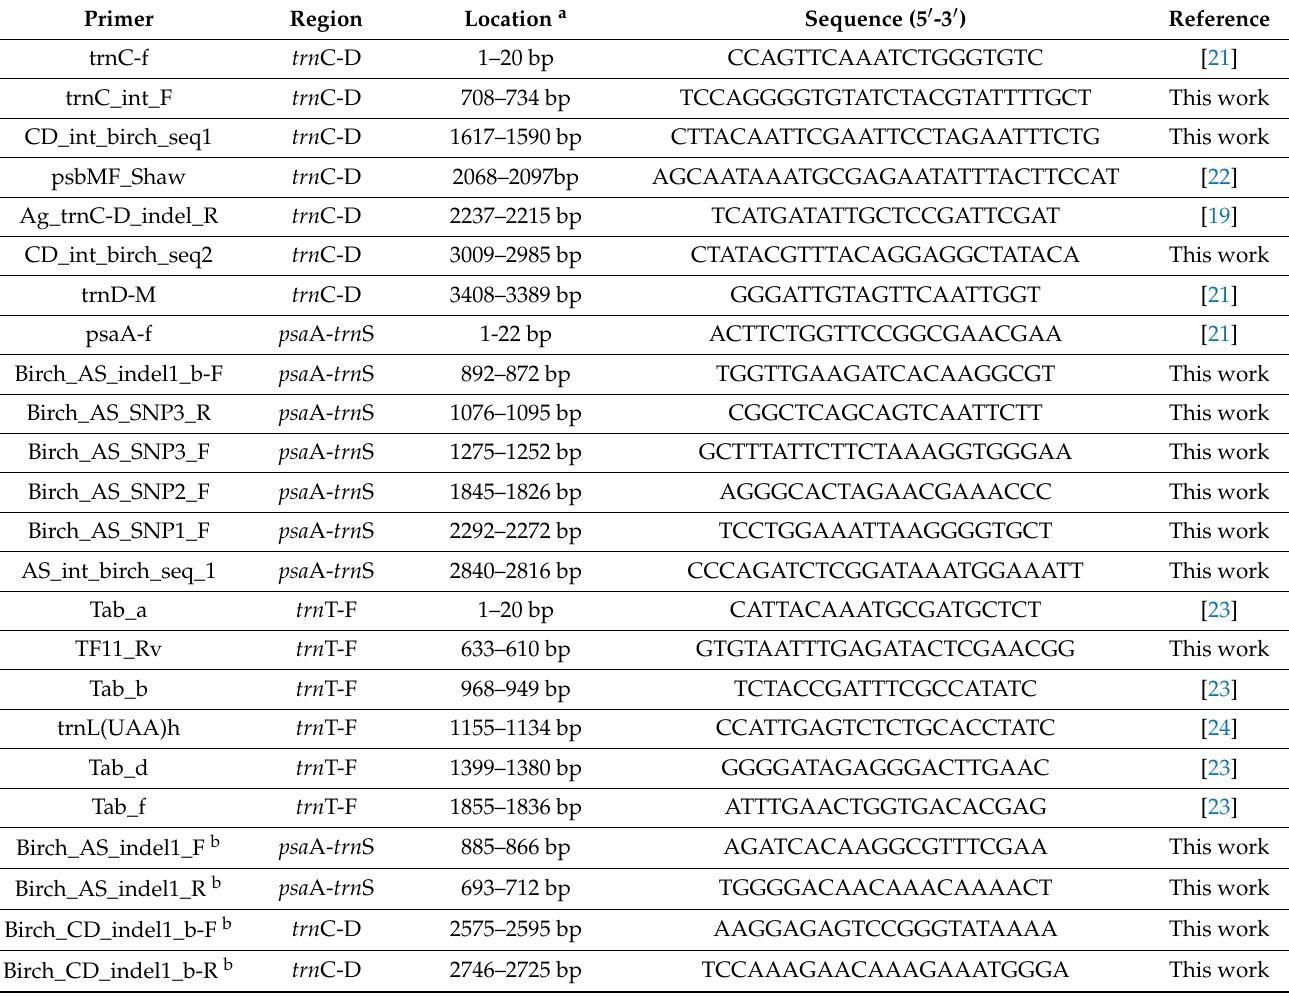
Table 2. List of primers used for sequencing and HRM analysis. Primer